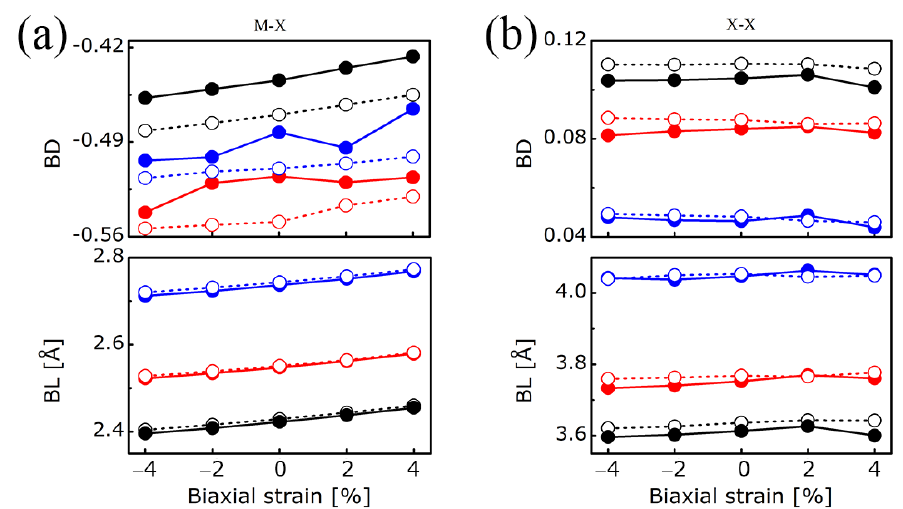
Figure 7. Bond degrees (BD) and bond lengths (BL) of ( a ) M-X and ( b ) X-X bonds in MX 2 bilayers (M = Mo, W; X = S, Se, Te) vs. biaxial strain. Mo: solid circle; W: hollow circle; S: black line; Se: red line; Te: blue line.